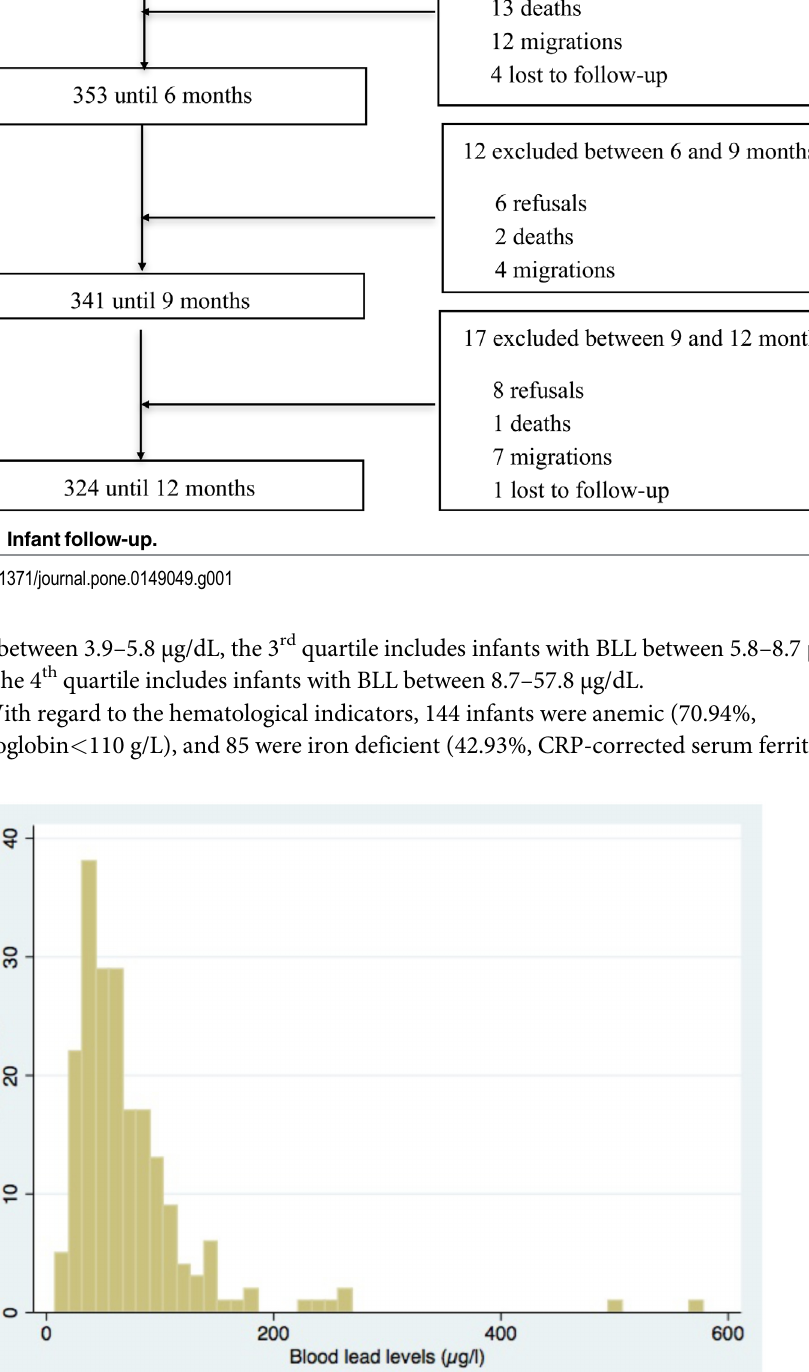
Fig 2. Distribution of the infant blood lead levels at 12